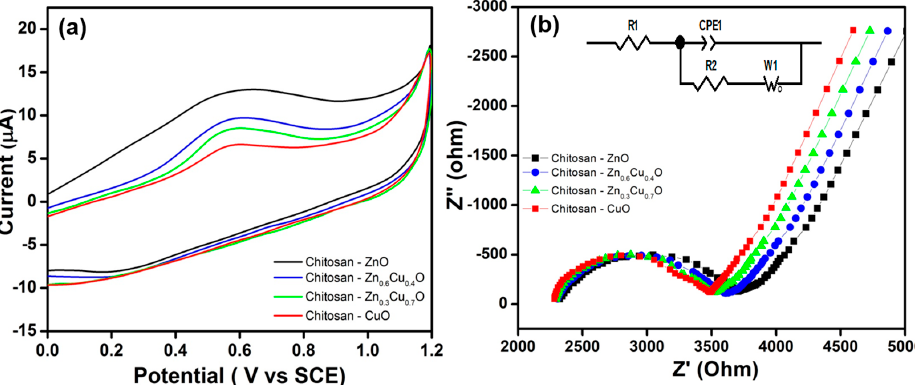
Figure 5. ( a ) CV curves and ( b ) impedance spectra for the electrosynthesized composite thin films. Inset—the Randomize-Simplex model fitted circuit consisting of resistor R 1 in series with a parallel combination of R 2 C 2 , which is in series with W 3 .